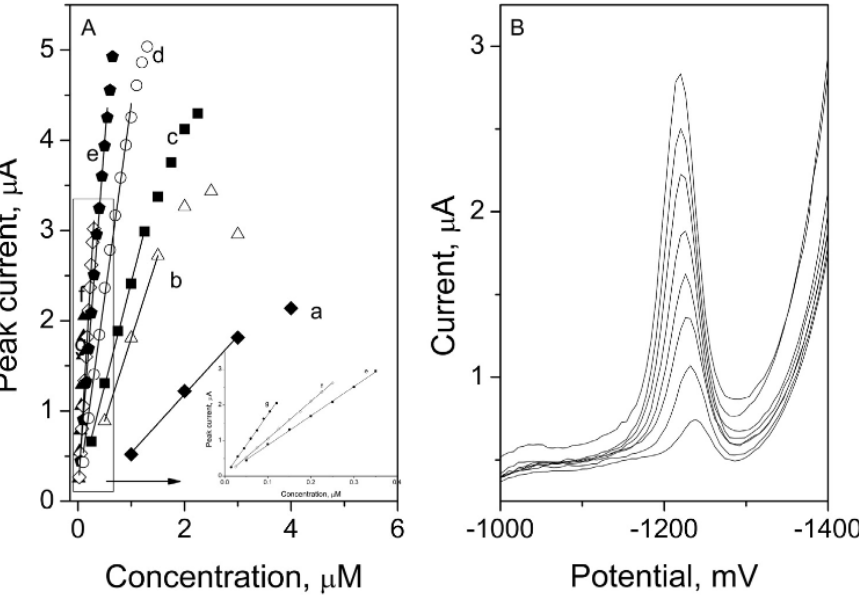
Figure 4. Spironolactone calibration graphs ( A ) with corresponding voltammograms for the preconcentration time of 20 s ( B ) measured on refreshable silver-based amalgam film electrode [339].